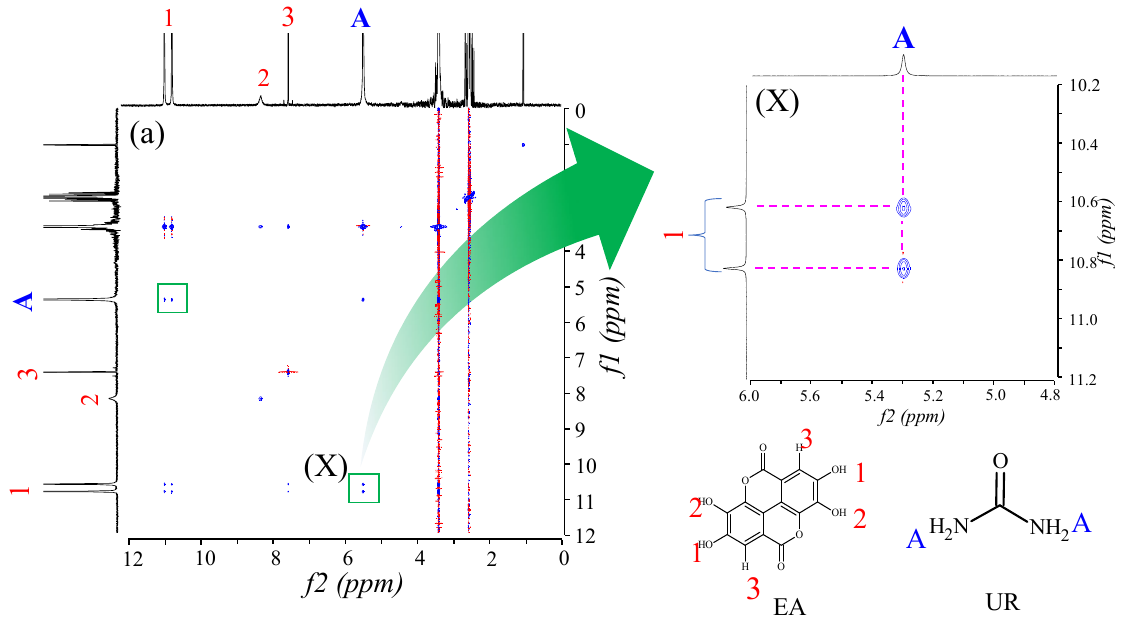
Figure 10. NOESY NMR spectra of EA/UR systems in DMSO-d6. ( a ) f1, 0–12 ppm; f2, 0–12 ppm ( X ); f1, 10.2–11.2 ppm; and f2, 4.8–6.0 ppm.